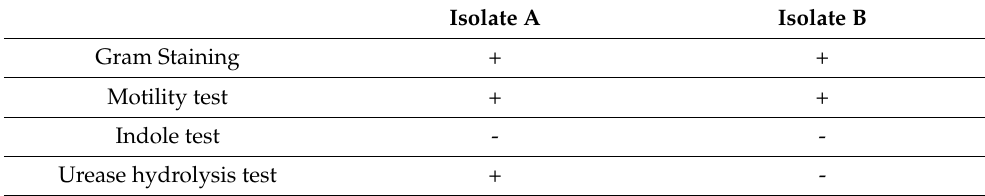
Table 1. The morphological and biochemical properties of Isolate A and Isolate